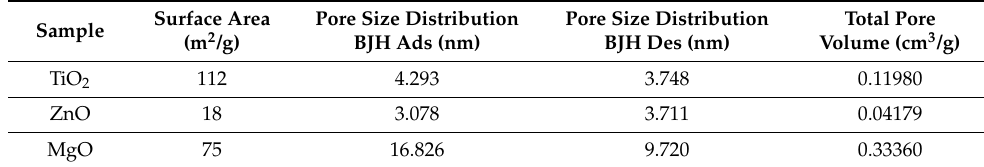
Figure 4. Adsorption–desorption isotherms for TiO 2 , ZnO and MgO materials. The MgO material is a type IVa isotherm with hysteresis of type H1. Type H1 hysteresis has also been found in networks of inkbottle pores where the width of the neck size distribution is similar to the width of the pore/cavity size distribution. The textural properties obtained from isotherms were presented in Table 2. Table 2. Surface area, pore size distribution and total pore volume calculated from adsorption–desorption isotherms for TiO 2 , ZnO and MgO materials.